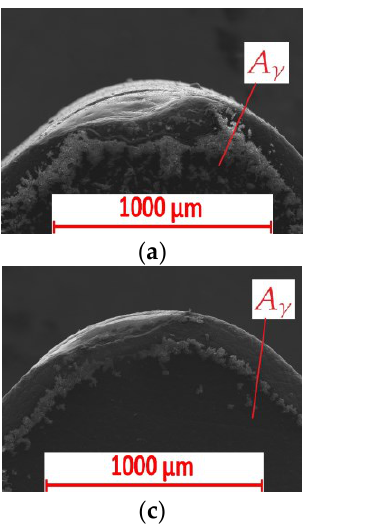
Figure 9. Results of tool ’ s wear measurements of cutting inserts after turning with f = 0.15 mm/rev of ( a , b ) FEPA 046 samples; ( c , d ) FEPA 100 samples: A γ — rake surface, A α — principal flank surface, A ’ α — auxiliary flank surface.